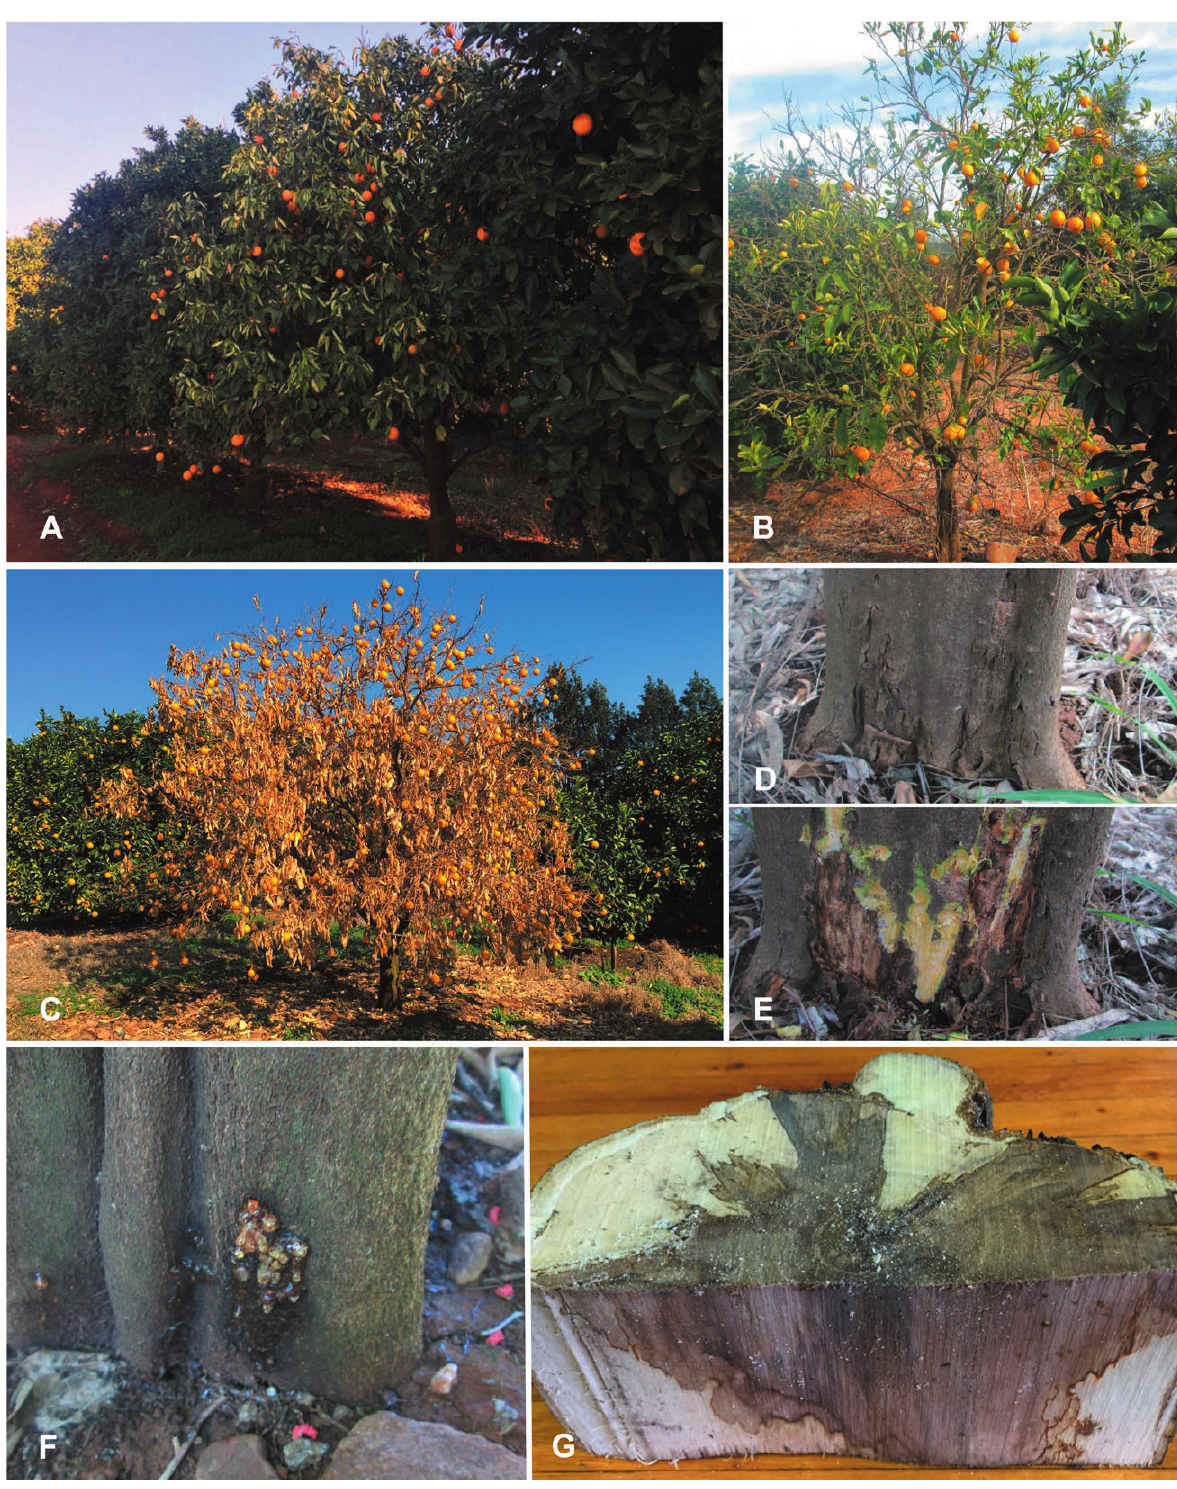
Figure 1. Dry root rot symptoms of citrus observed in South Africa. Tree decline progression: initial leaves wilting (A), yellowing, loss of leaves, and dieback of branch tips (B) and plant death (C). External cracks or blisters on the trunk portion above the crown (D) and inter- nal dry rot (E) of the same plant. Gum exudate at the crown level (F). Brown to black discolouration and necrosis of the vascular tissue vis- ible in longitudinal and transverse sections (G